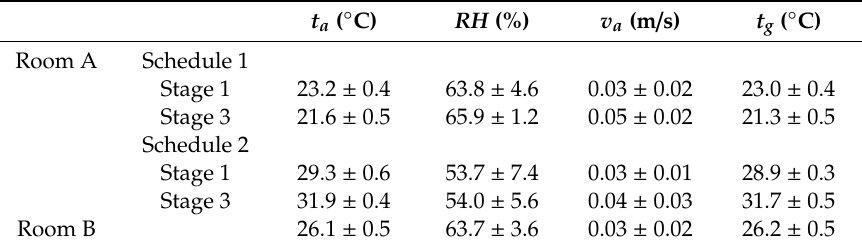
Table 3. Thermal environment during the